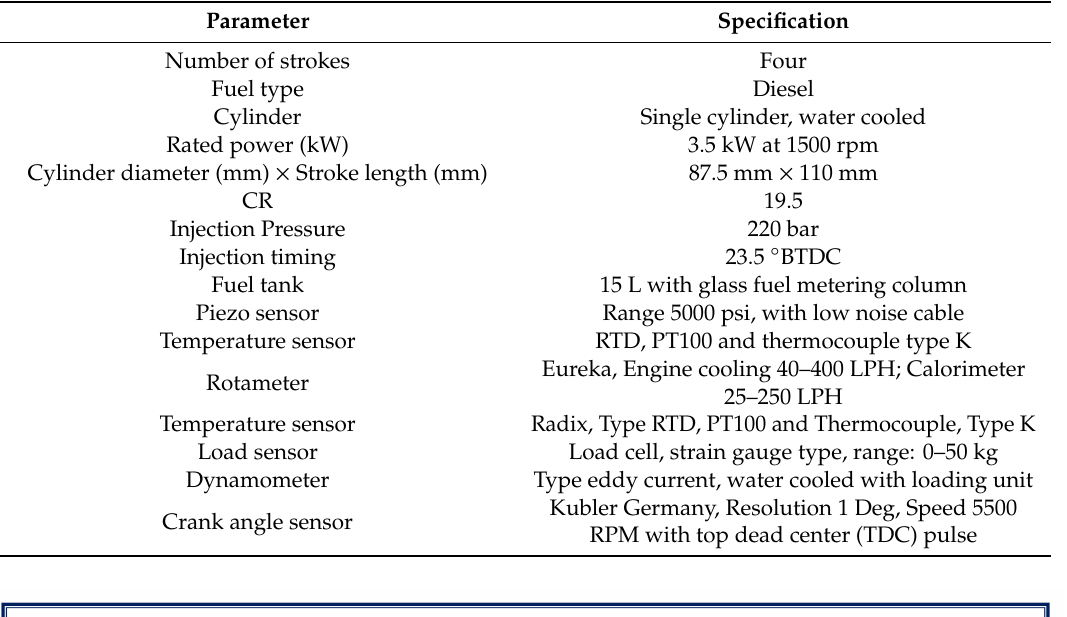
Table 2. Specifications of VCR engine test bed used in the current study.